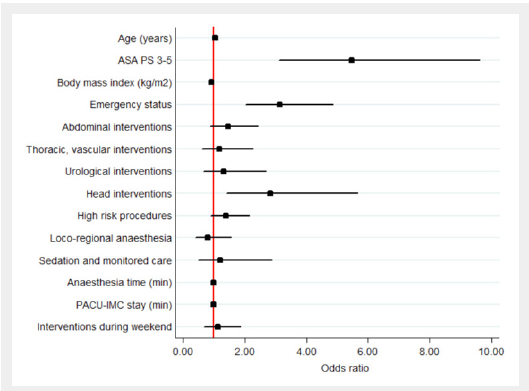
Odd ratios for 30-day in-hospital death in patients with PACU stay (A) and in patients with IMC stay (B) (multivariate model). PACU stay 3 hours to ≤6 hours was assessed versus PACU stay <3 hours; IMC stay >24 hours versus IMC stay 6 hours to ≤24 hours. ASA PS 3‒5 was assessed versus ASA PS 1–2; emergency (nonelective) status versus elective; abdominal, thoracic – vascular, urological, head intervention versus orthopaedic; high-risk procedures versus low- and intermediate-risk procedures; locoregional anaesthesia, sedation and monitored care versus general and combined anaesthesia; interventions during weekend versus interventions during weekdays. ASA PS = American Society of Anesthesiologists Physical Status score; ICM = intermediate care unit; PACU = post anaesthesia care